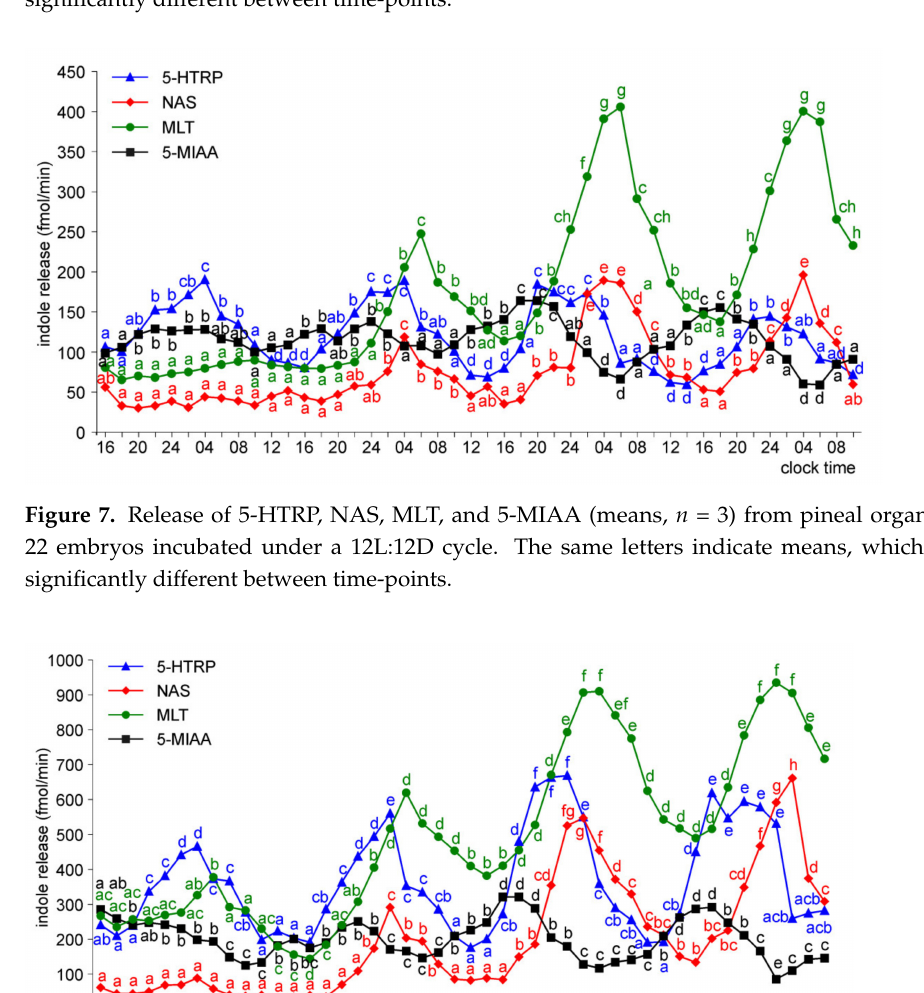
Figure 6. Release of 5-HTRP, NAS, MLT, and 5-MIAA (means, n = 3) from pineal organs of ED 20 embryos incubated under a 12L:12D cycle. The same letters indicate means, which are not significantly different between time-points.